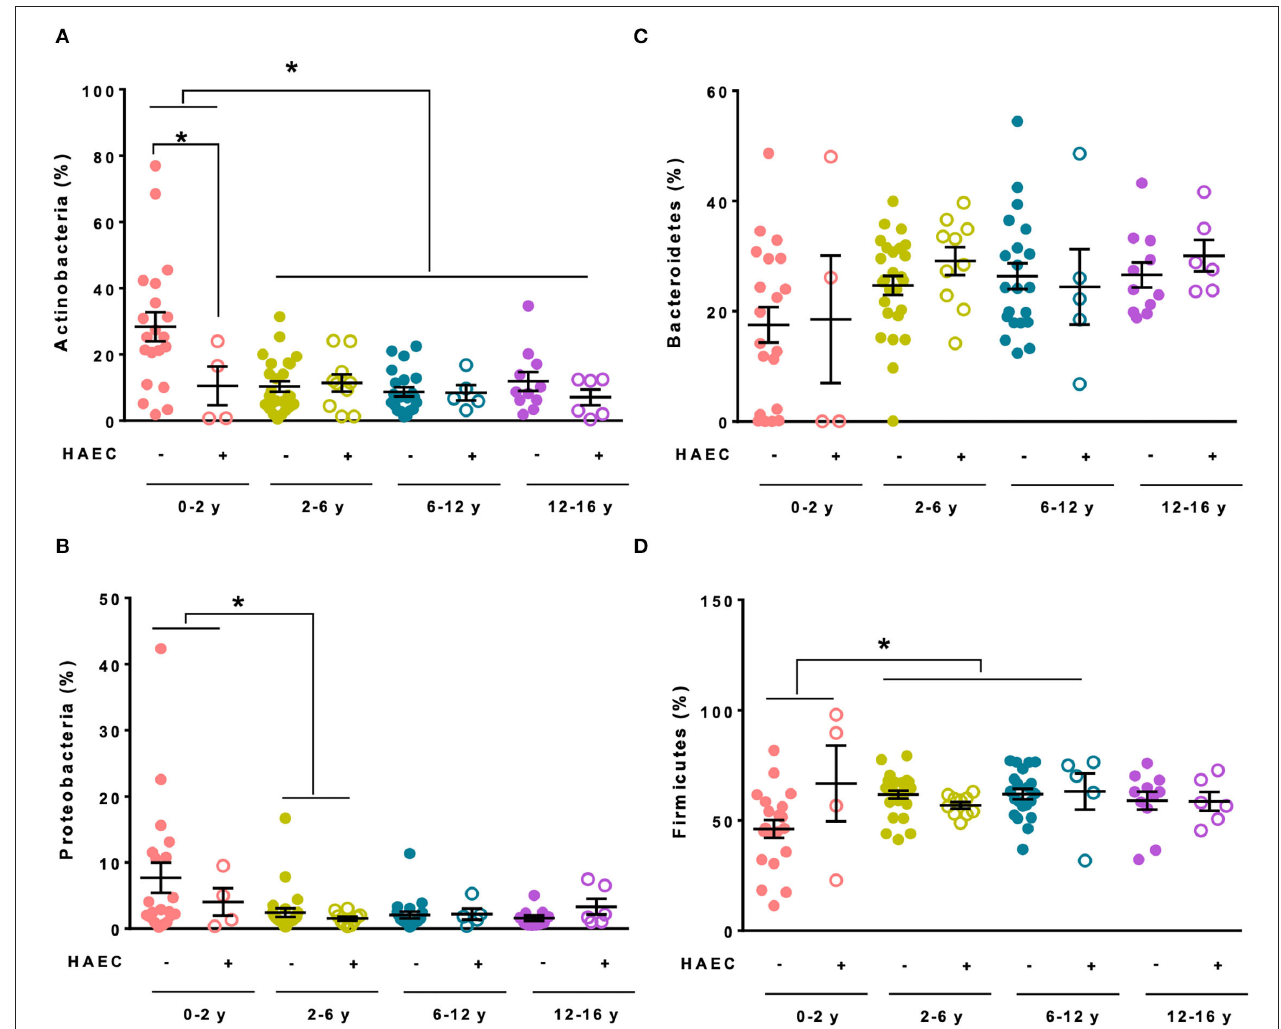
FIGURE 4 | Main phyla relative abundances of fecal microbiota in the MICROPRUNG cohort. Relative abundance of Actinobacteria (A) , Proteobacteria (B) , Bacteroidetes (C) , and Firmicutes (D) in function of age group and Hirschsprung-associated enterocolitis status. * P < 0.05. and only exclusive or mixed vs. no breast-feeding at all was